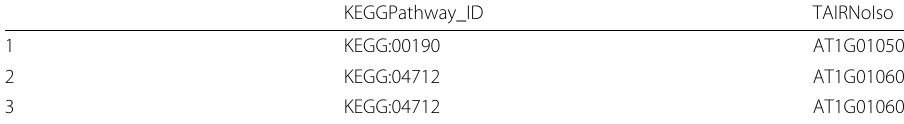
Table 12 Examples of pairs of pathways identifiers and proteins extracted from the KEGG database